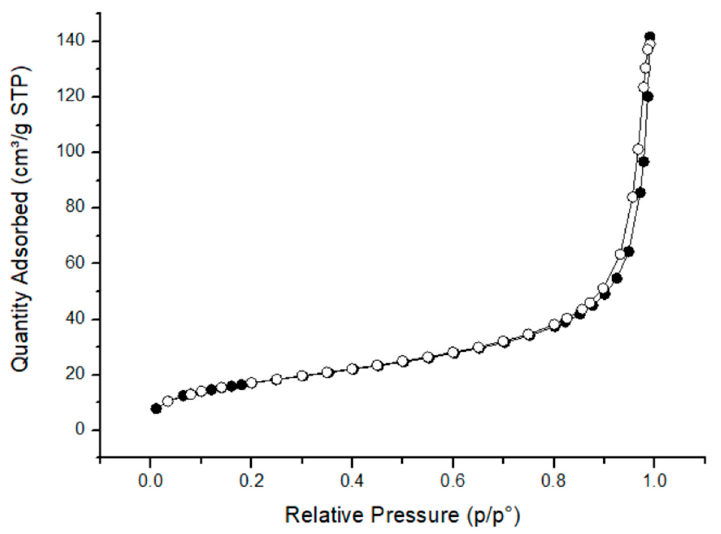
Figure 4. N 2 adsorption/desorption isotherms of PolyCat-Si registered in the relative pressure range p/p 0 equal to 0–1.0.